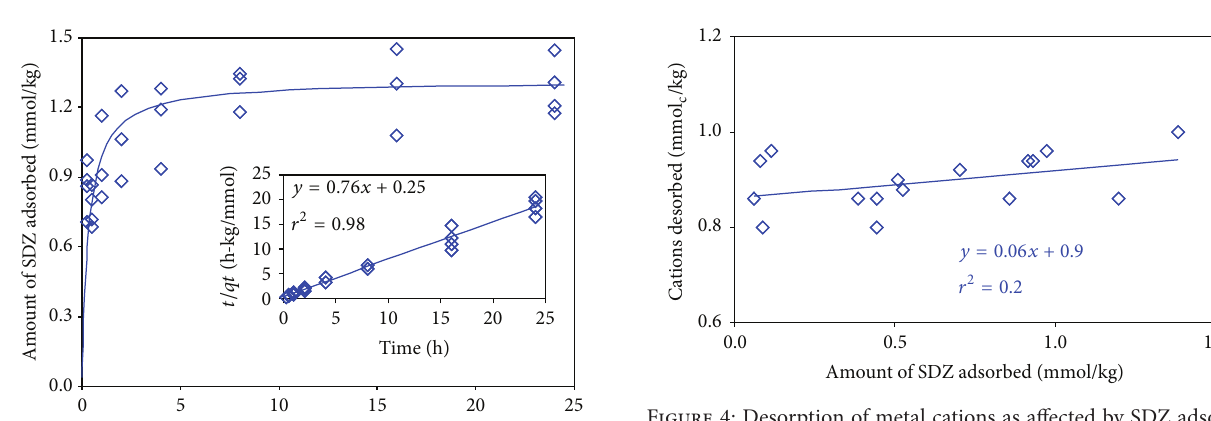
Figure 4: Desorption of metal cations as affected by SDZ adsorp-